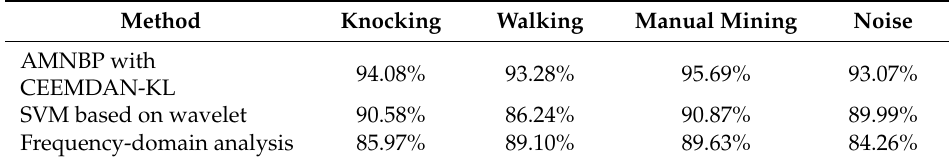
Table 3. The recognition results of four types of events. SVM: Support vector machine.